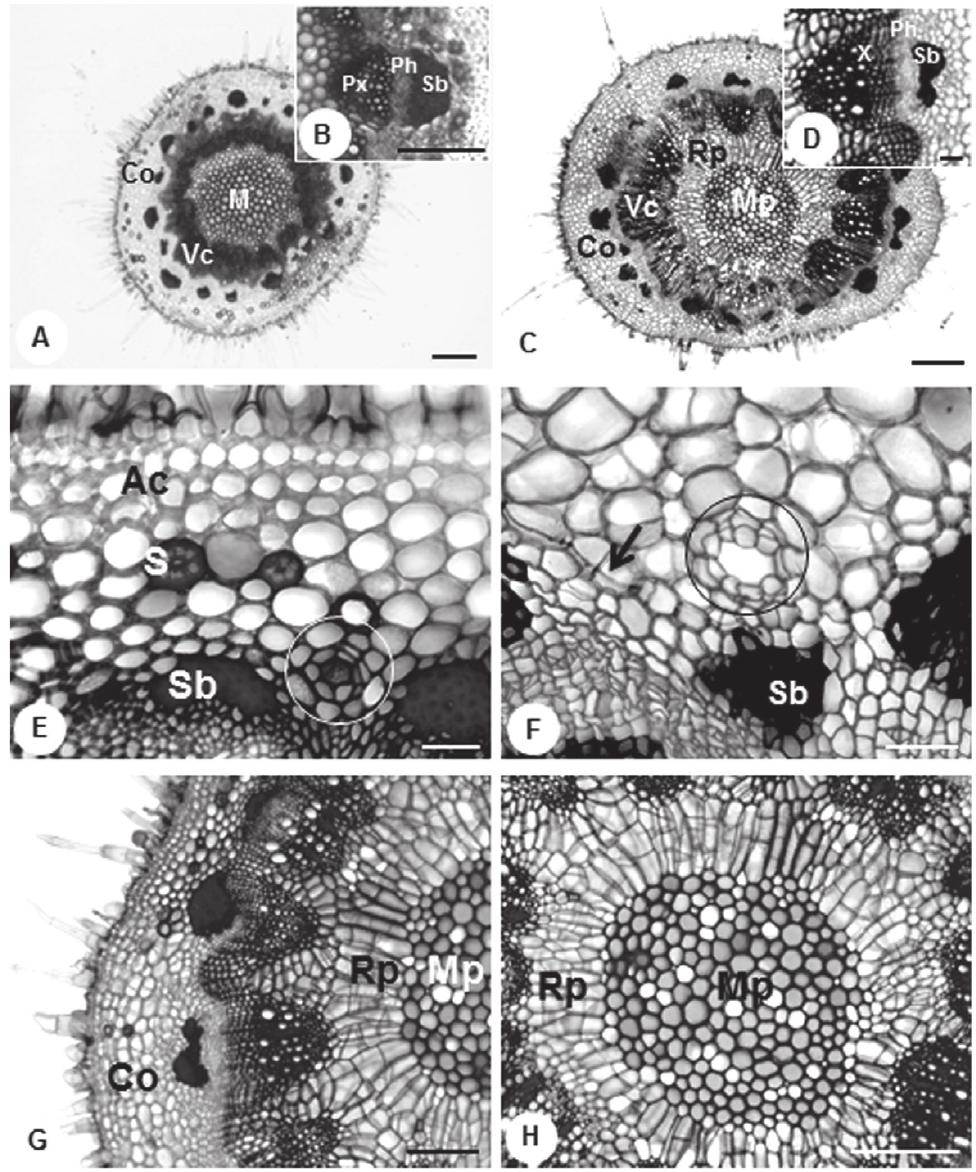
Fig. 2 - Aerial stem of Dimerostemma vestitum . (A, B) Transversal sections of the apical portion (A) highlighting cell wall thickening in the medullar region (M), vascular cylinder (Vc) and cortex (Co). Details of the collateral vascular bundle (B) with primary xylem (Px), phloem (Ph) and sclerenchyma bundles (Sb); (C, D) Basal portion of the aerial stem. General view (C) highlighting medullar parenchyma (Mp), radially arranged cells (Rp), vascular cylinder (Vc) and cortex (Co). Detail of the vascular cylinder (D) showing the formation of the vascular cambium and xylem (X), phloem (Ph) and sclerencyma bundle (Sb). (E) Detail of angular collenchyma (Ac) layers beneath the epidermis, isolated sclereids (S), sclerenchyma bundles (Sb) and secretory canal (circle); (F) Formation of a secretory canal (circle) and evidence of endodermis with Casparian strips (arrow) and sclerencyma bundles (Sb). (G) Stem in the basal portion, showing detail of the vascular cylinder, cortical (Co) and medullar region (Rp, Mp). (H) Distinction of the medullar parenchyma (Mp) in a central region and another peripheral, with radially arranged cells (Rp). Scale bars: 1000 µm (A, C); 100 µm (B, E, F); 200 µm (D); 500 µm (G,